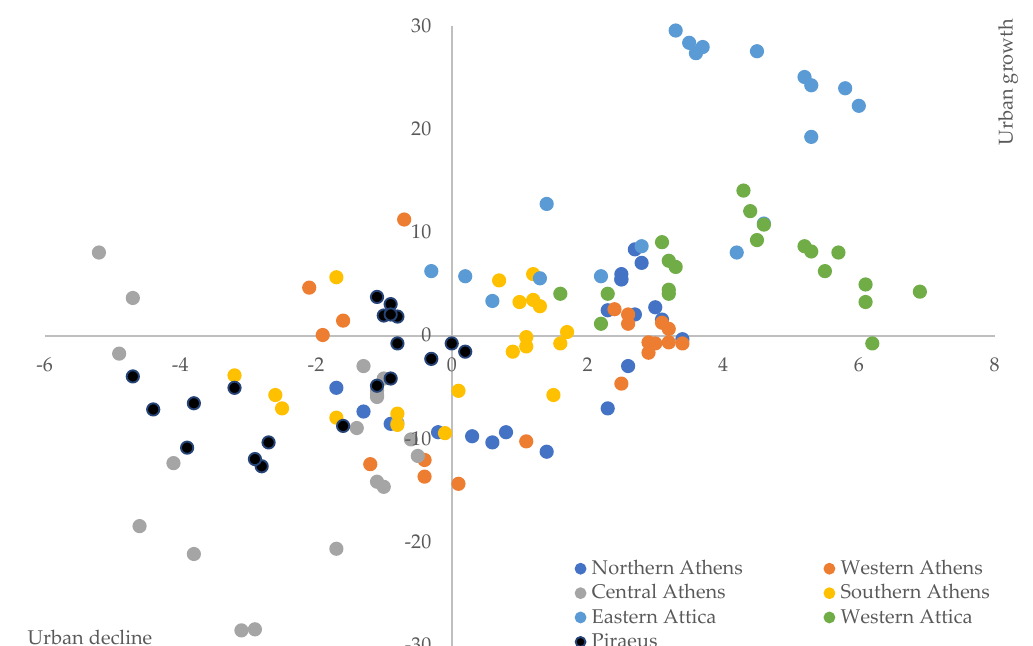
Figure 5. The relationship between natural balance (x-axis) and migration balance (y-axis) by year and regional unit in the study area (2000–2020) taken as a proxy of urban growth or decline (source: our elaboration on ELSTAT demographic register).